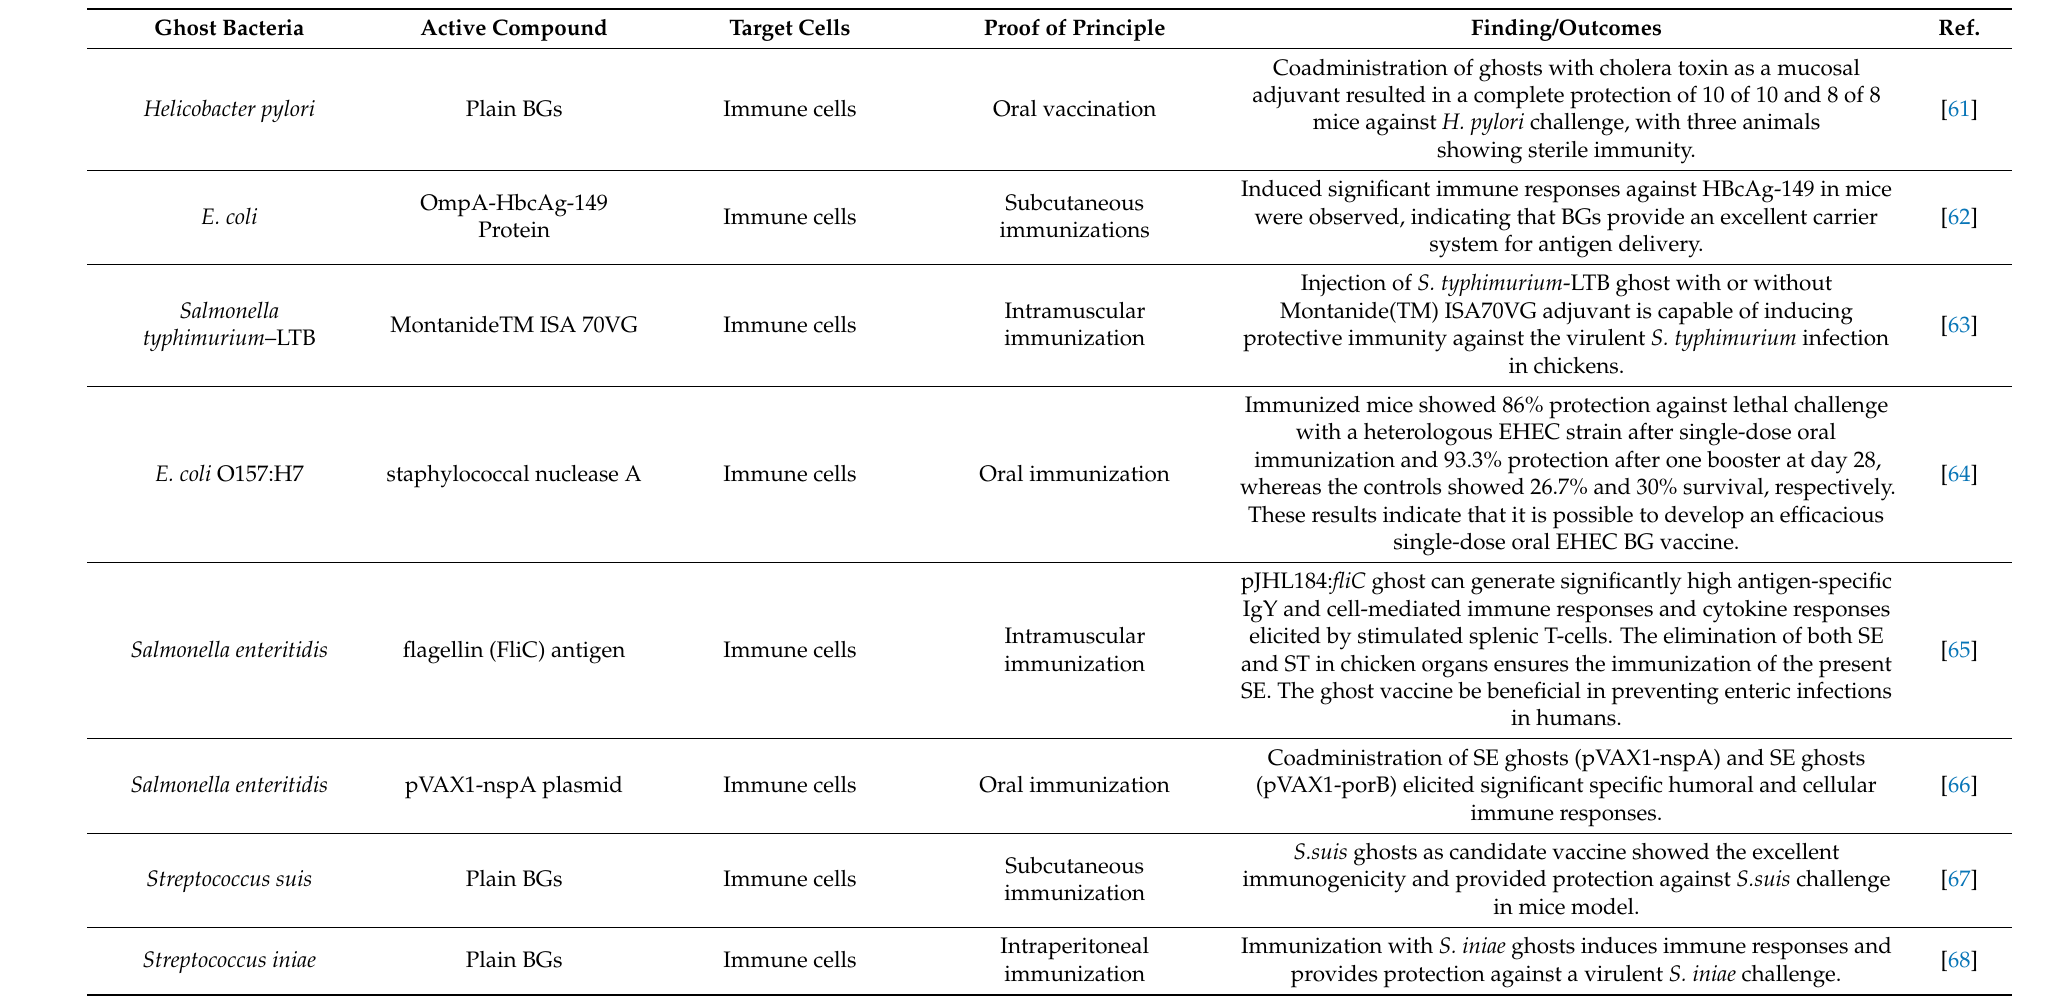
Table 3. Examples of BGs application as delivery system for recent experimental